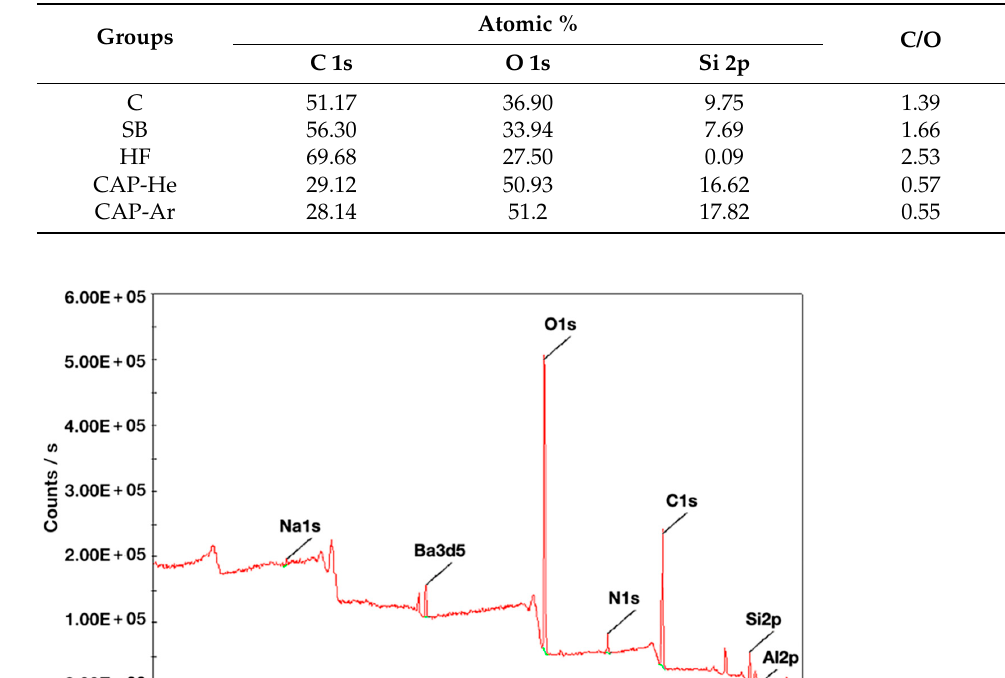
Table 4. Main chemical compositions on RNC surfaces.